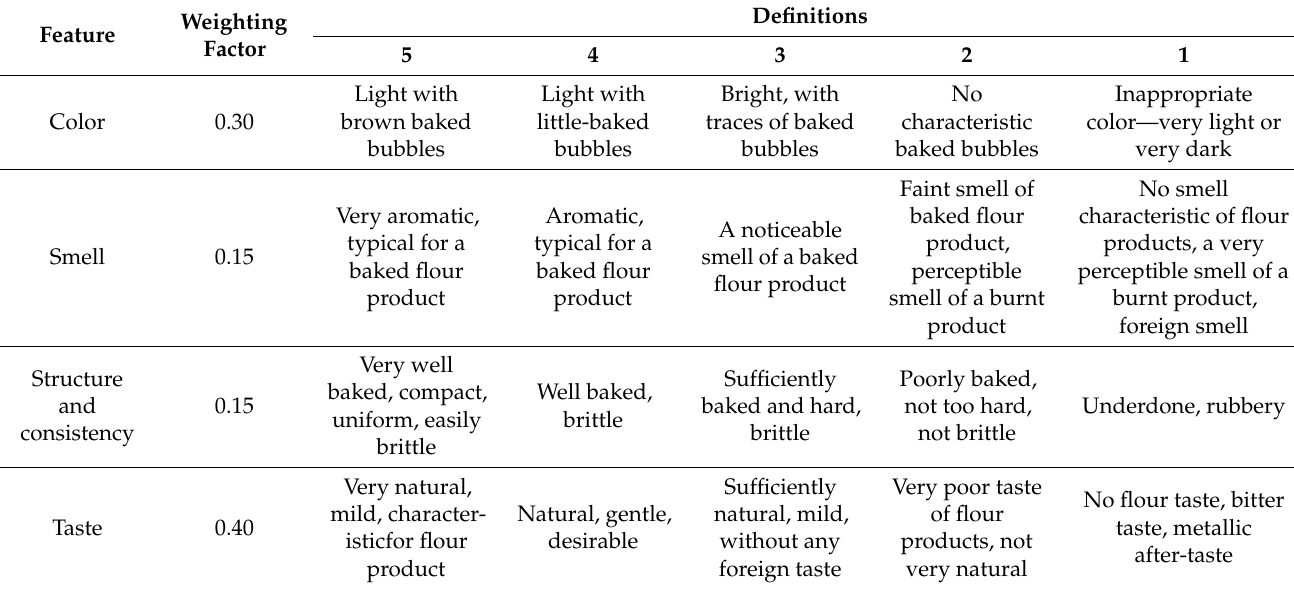
Table 7. Scheme of the 5-point rating